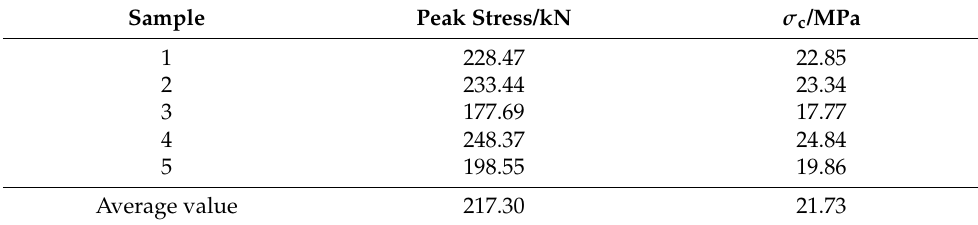
Table 1. Uniaxial compressive strength of each sample ( σ c is compressive strength).